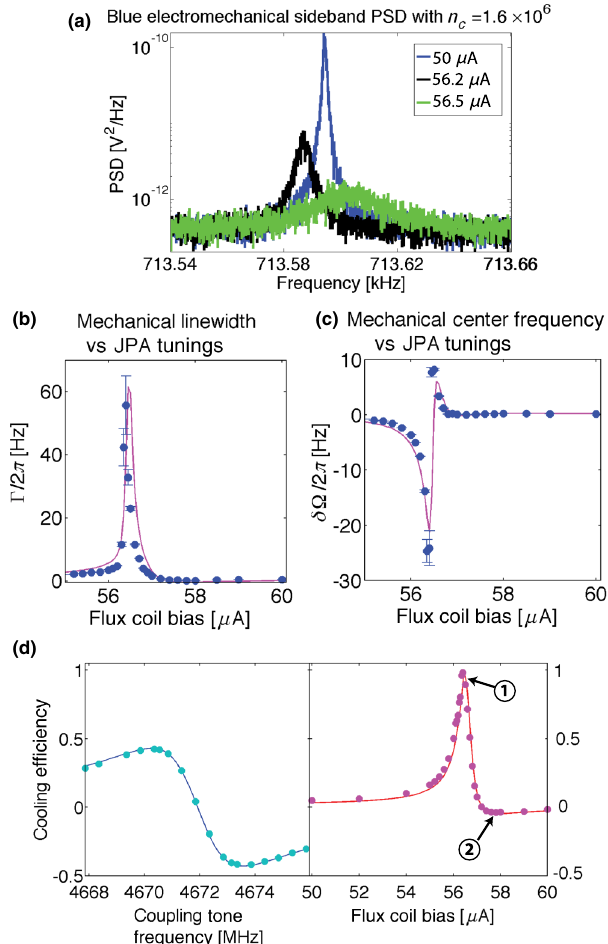
FIG. 3. The network’s mechanical response. (a) Employing ¼ 1 : 6 (cid:2) 10 6 , the power spectral density (PSD) of the blue, n c thermally excited mechanical sideband is shown for three flux settings [the same flux settings as in Fig. 2(d)], keeping the coupling tone fixed at 4.672 GHz. (b) The points represent the observed linewidth of blue thermal sidebands as the JPA is tuned, employing a coupling tone at a fixed frequency and power such ¼ 1 : 6 (cid:2) 10 6 . The line is a theoretical prediction with no that n c free parameters. (c) From the same experiment, the observed changes in the MO center frequency and theoretical prediction are shown. (d) CE, as inferred from ring-down measurements and measured red and blue sideband powers. Left: CE for different coupling tone frequencies when the JPA is far detuned. Right: CE for a fixed coupling tone and different JPA tunings. The lines are theoretical predictions. The numbered call outs in the right plot correspond to the JPA tunings used in Fig.